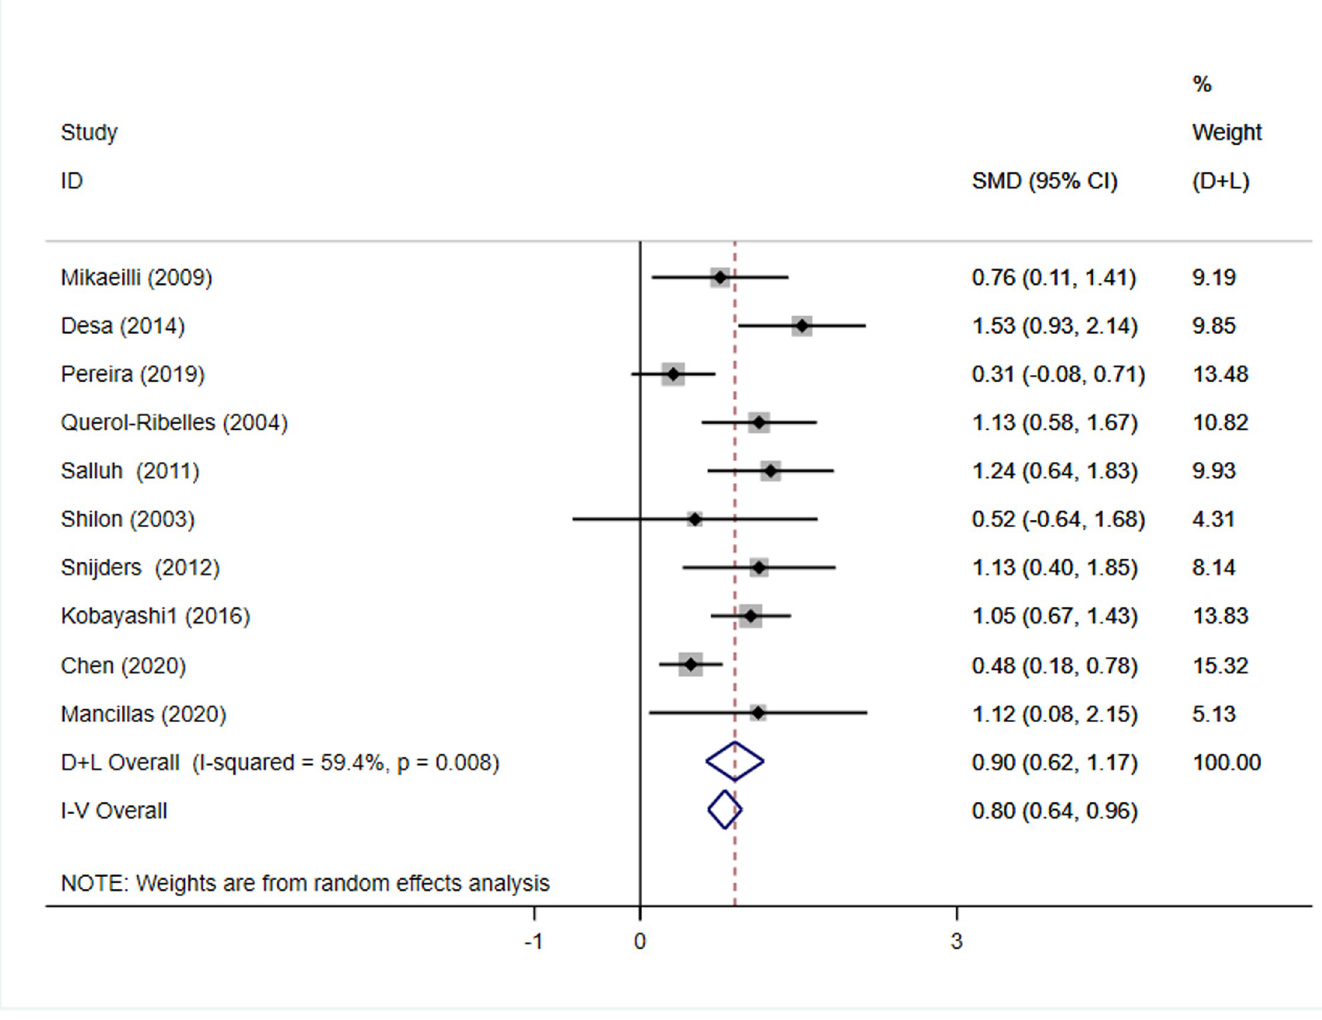
Fig 4. Forest plot of D-dimer in non-survivors versus survivors with CAP. There was a significant elevation of D-dimer level in non-survivors with great of heterogeneity between trials. CAP, community-acquired pneumonia.